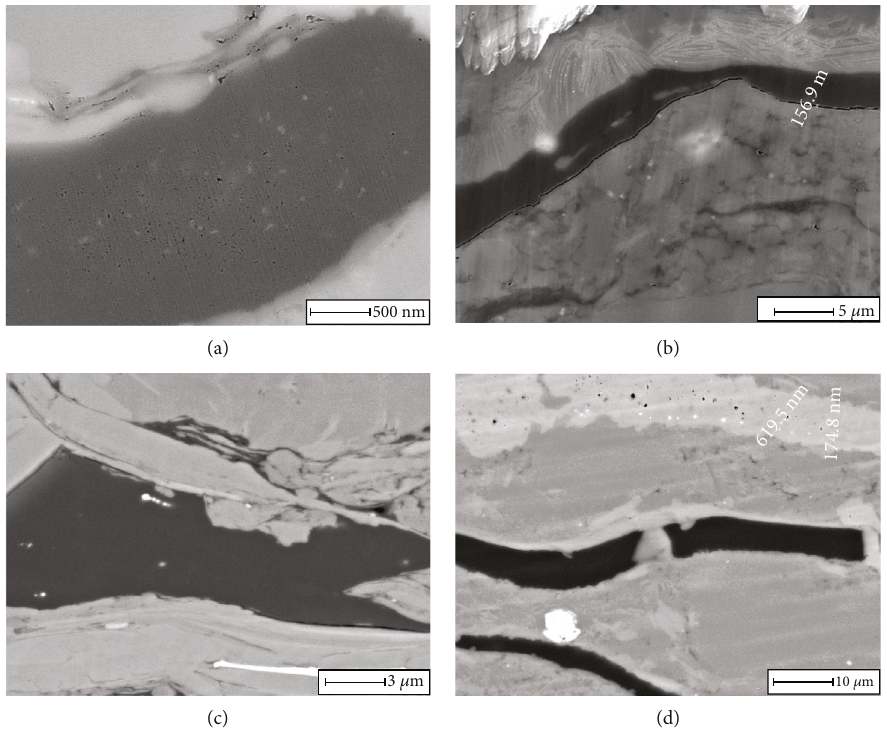
Figure 10: The pore characteristics of graptolite in the Wufeng-Longmaxi Formation shale at the southeast Sichuan